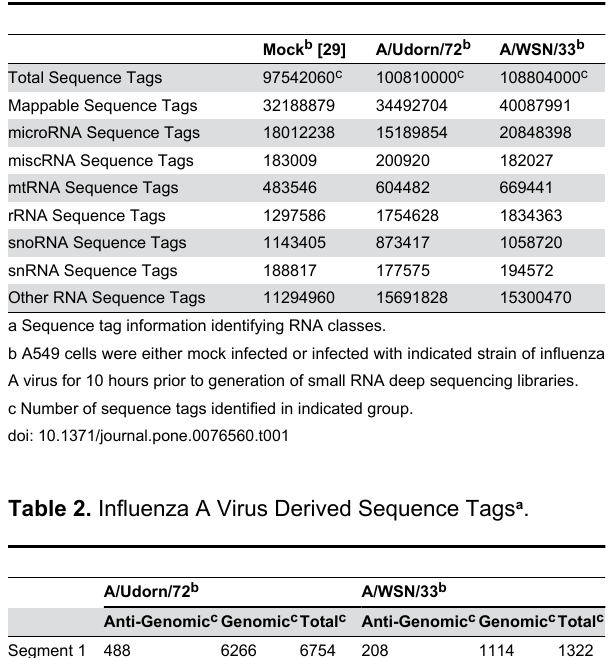
Table 1. Sequence Tag Statistics a .